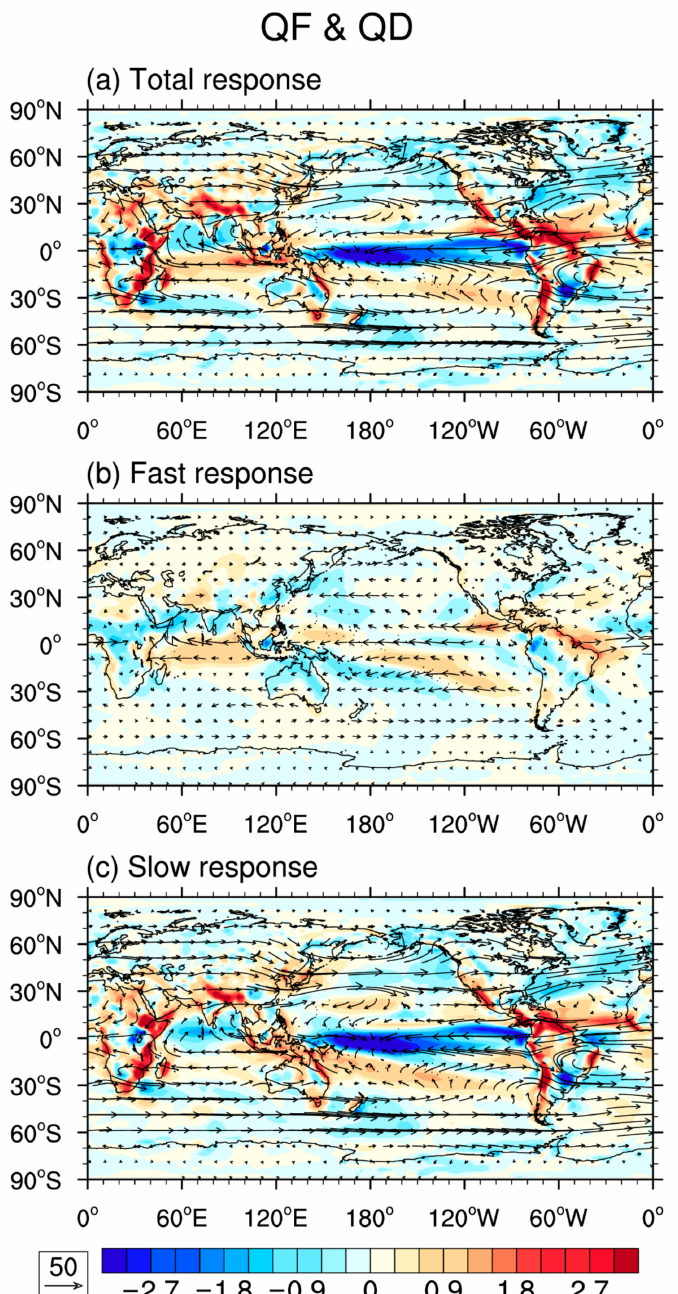
Figure 8. ( a ) Total, ( b ) fast, and ( c ) slow responses of global vertical integrated column horizontal water vapor flux (QF, vector, and units: kg m − 1 s − 1 ) and divergence (QD, colour shading, units: 10 − 5 kg m − 2 s − 1 ; positive values represent water vapor